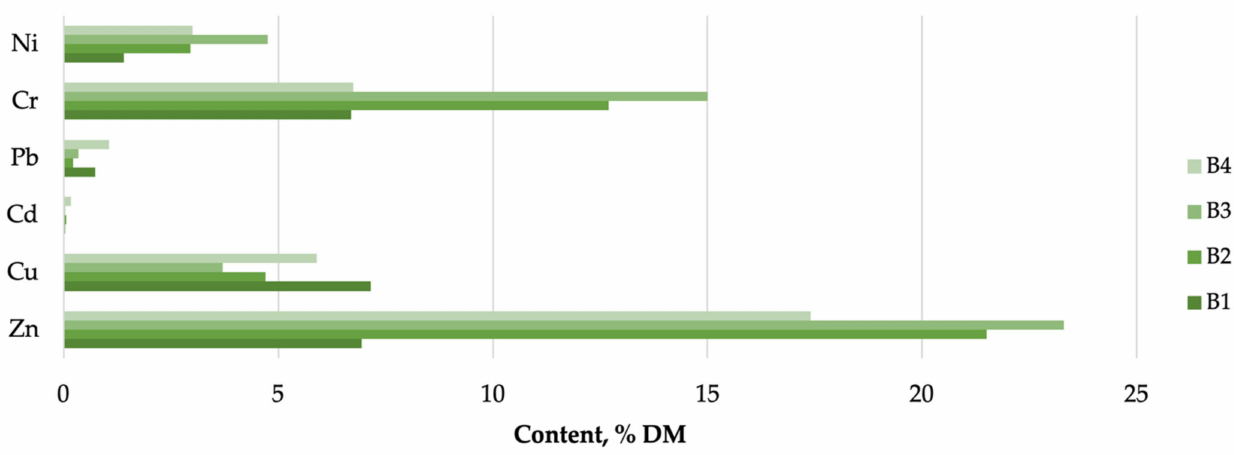
Figure 3. Separate trace elements and heavy metals content in C. glomerata biomass from different rivers in Lithuania (Dubysa (B1); Šventoji (B2); Nev˙ežis (B3); J¯ura